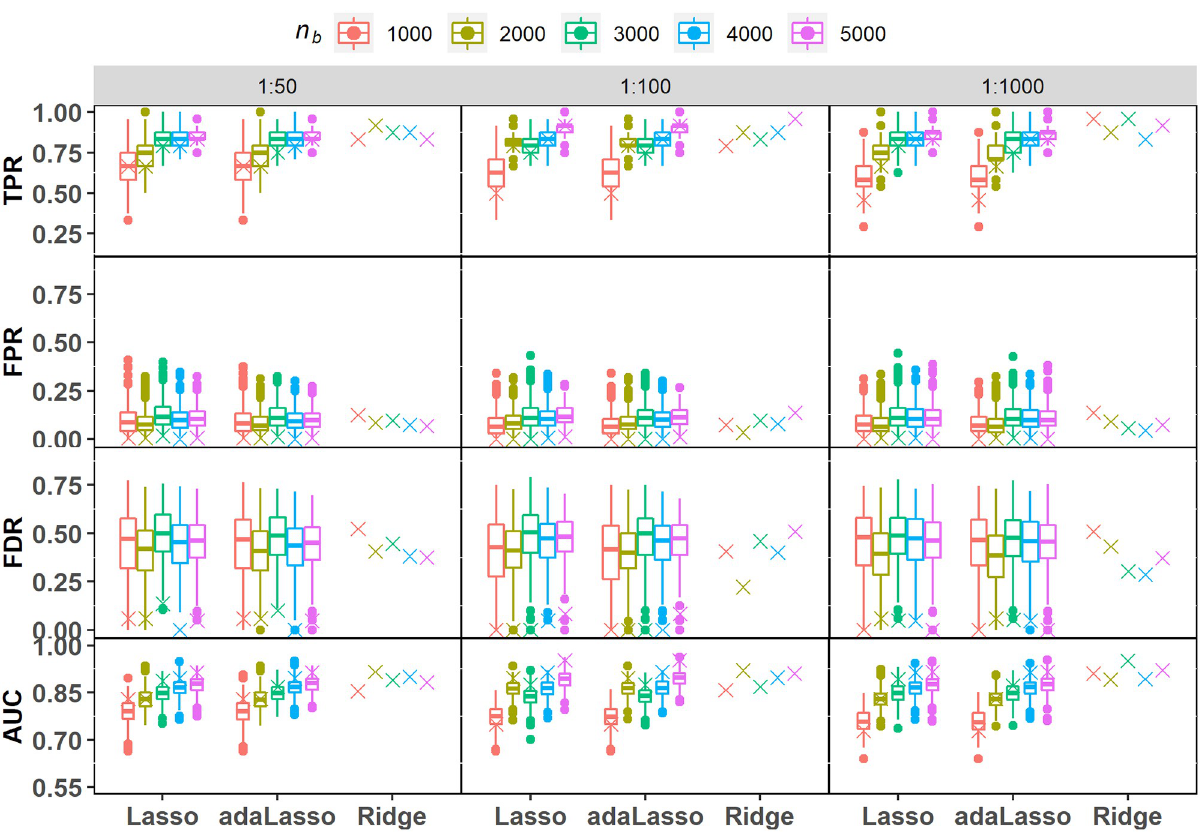
Fig 4. Simulation under UNCOR-24. Performance metric scores for variable selection based on the SVRS algorithm (symbol x) and corresponding distributions across 500 individual fits of each regularization model with imbalance ratios 1:50, 1:100 and 1:1000. Performance scores for individual ridge regression fits are not applicable as it does not perform automatic variable